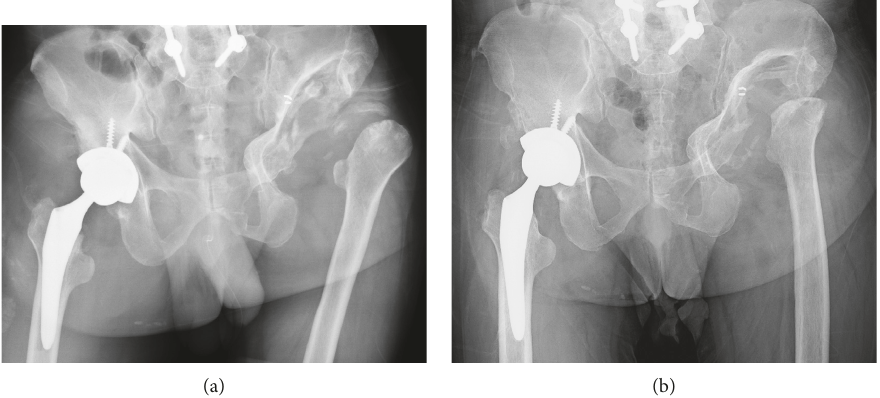
Figure 4: Case 2 postoperative hip X-rays. (a) Immediately after operation. (b) Five years after operation. There were no clinical signs of implant loosening in the hip